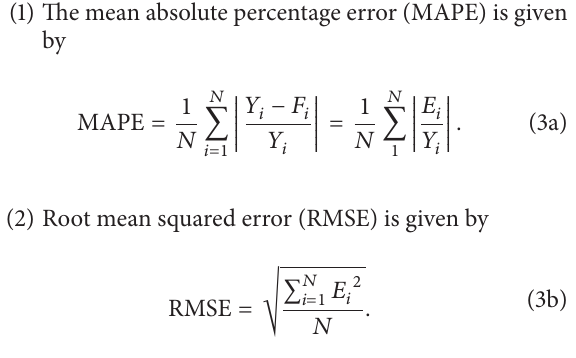
original is much better. So we chose the original time series to do this prediction for the September